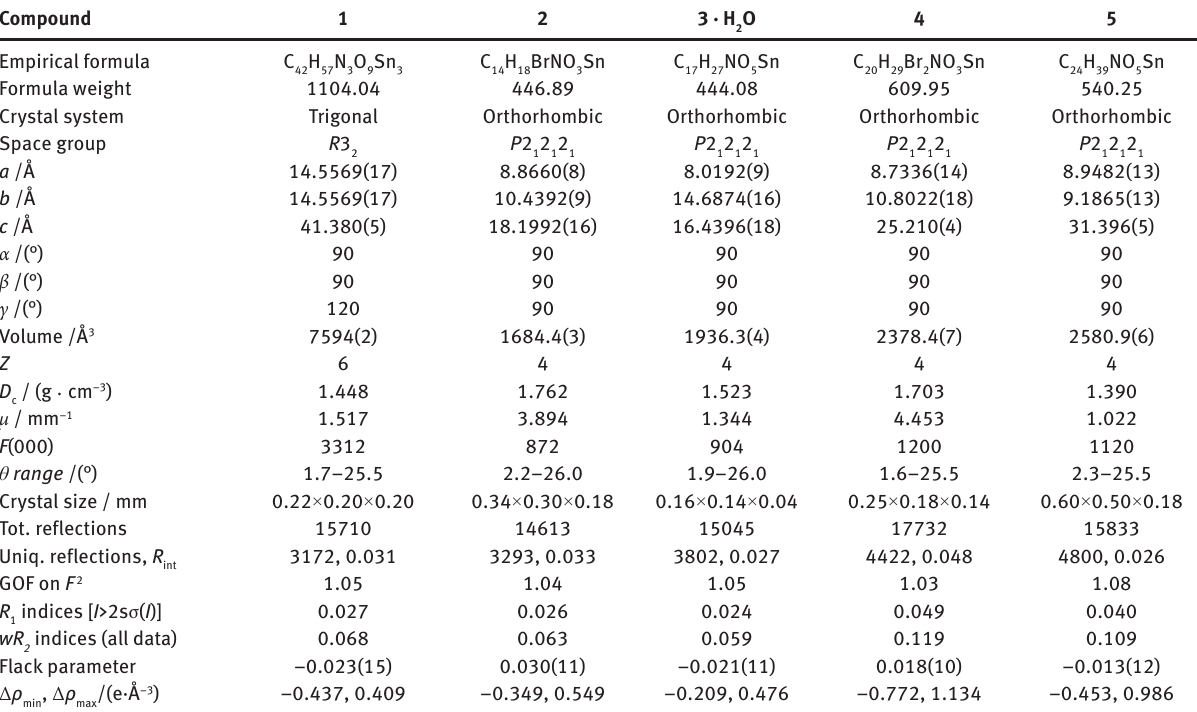
Table 3: Crystallographic and refinement data for